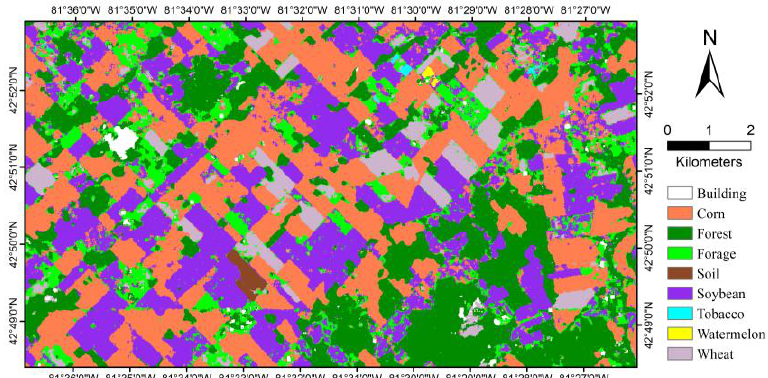
Figure 5. The classification map using ND-RF method with all 11 RADARSAT-2 images.